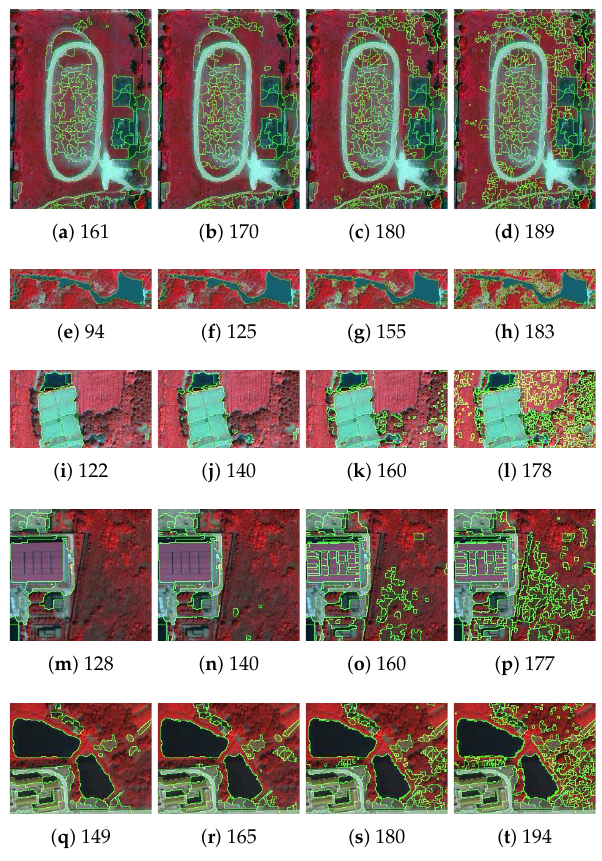
Figure 6. Segmentation by setting four different threshold applied for generating spectral-index markers based on